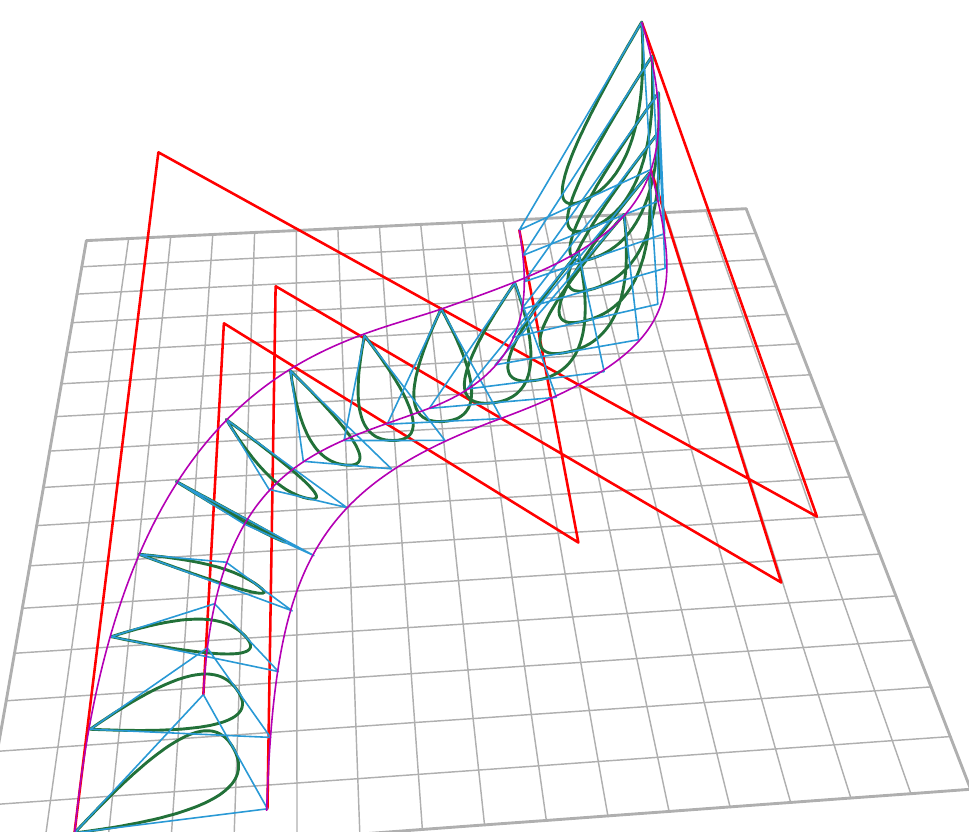
Figure 15. Homothetic splines (magenta) and their regular division into secondary geometry (blue). These create a secondary set of splines